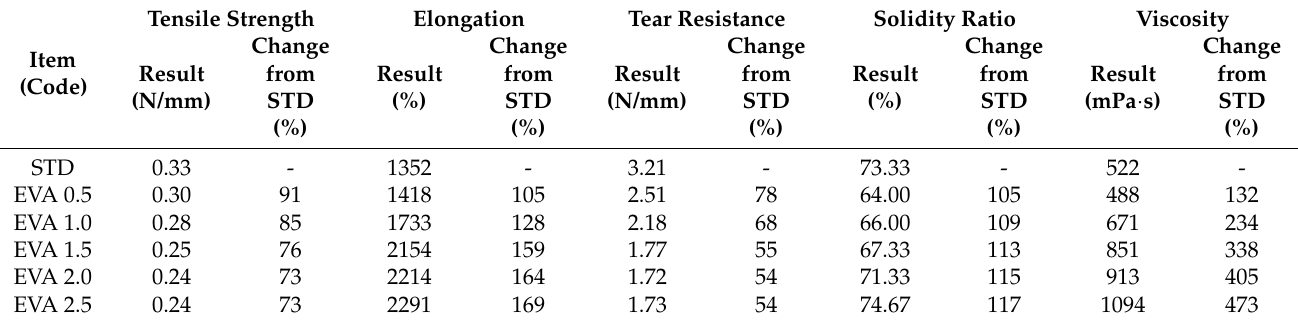
Table 9. EVA physical property results according to input amount and increase/decrease rate compared to